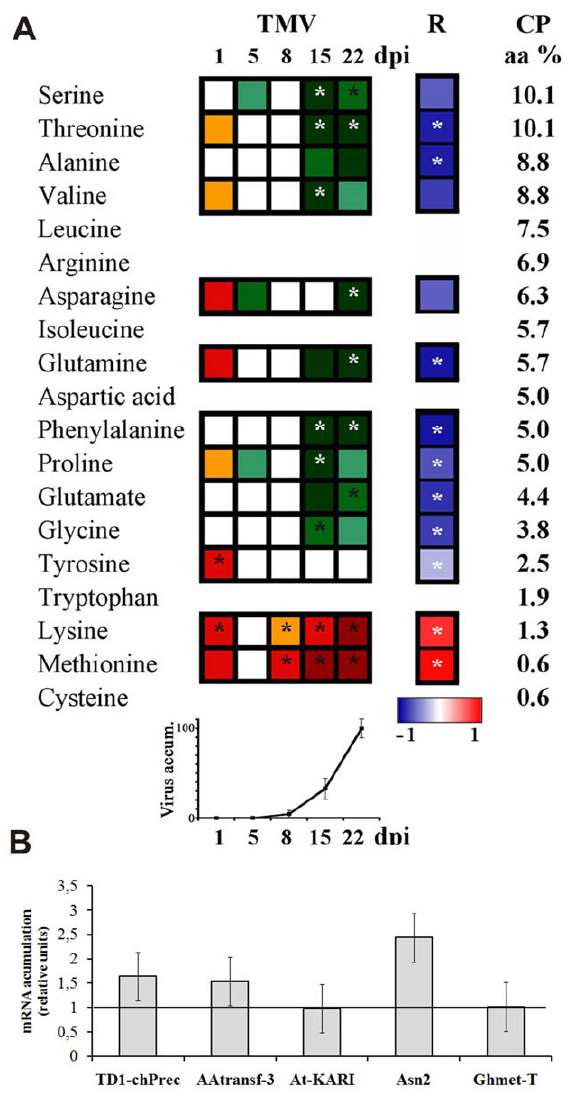
Figure 4. Relative abundance of free amino acids in TMV infected Plants. A ) Changes in the relative abundance of free amino acids between TMV-inoculated and control plants detected by GC-MS experiments (same data as Figure 2). Pearson correlation between CP and free amino acids levels was calculated and the correlation coefficients R are showed on a blue-red false color scale. Asterisks indicate statistically significant correlations ( P , 0.01). Amino acid composition of CP is listed as a percentage of abundance (aa %) and CP accumulation during virus infection is shown as line graphic. B ) Relative mRNA accumulation of genes involved in amino acids synthesis detected by qPCR: TD1-chPrec=chloroplast threonine deaminase 1 precursor, AAAtransf3=Branched-Chain Amino Acid Aminotransferase 3, AtKARI=similar to A. thaliana ketol-acid reductoisomerase, Asn2=As- paragine Synthetase 2, GHmetT=Glycine